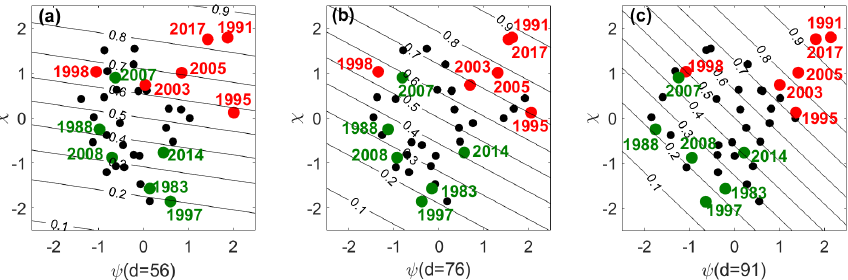
Figure 4. Scatter plots of the 39-year sample in the space of covariates ψ(d) vs. χ for (a) 26 May ( d = 56), (b) 15 June ( d = 76) and (c) 30 June ( d = 91). Groups of severe (weak) years are identified by the red (green) circles. The straight lines are contours of P exc (ψ, χ) .